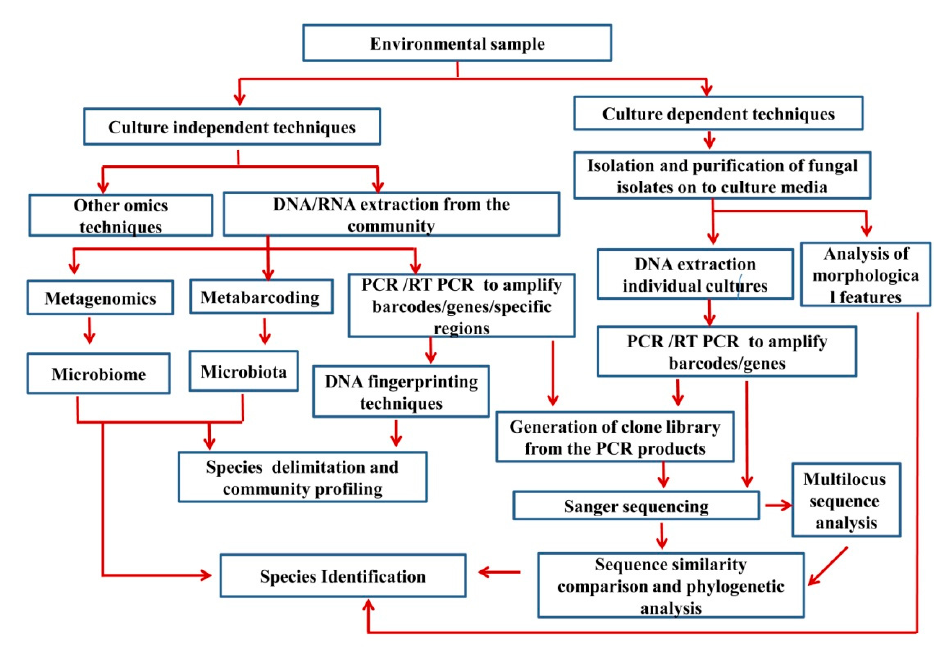
Figure 1. Basic steps in both culture-dependent and culture-independent methods.